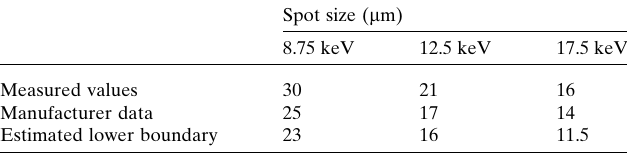
Table 2 Comparison of spot sizes measured, given by the manufacturer and geometrically